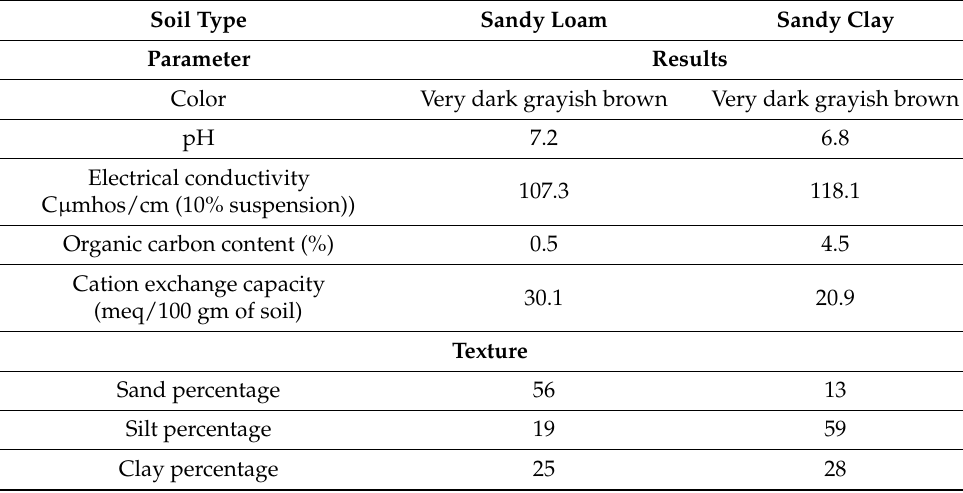
Table 4. Calculation of soil physicochemical properties.